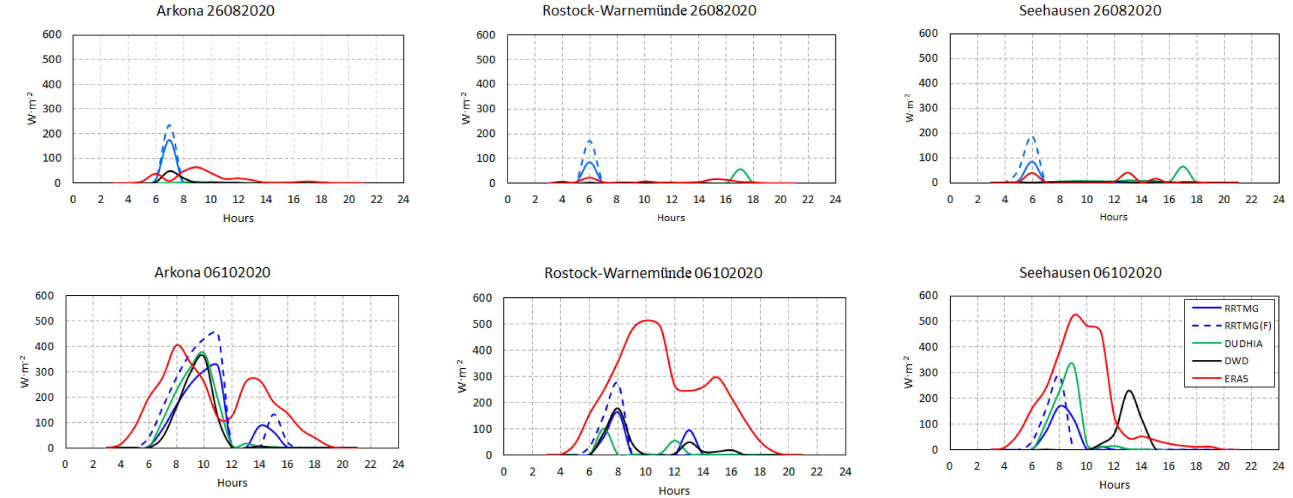
Figure 14. Diurnal distribution of the direct radiation values for the occulted fronts.